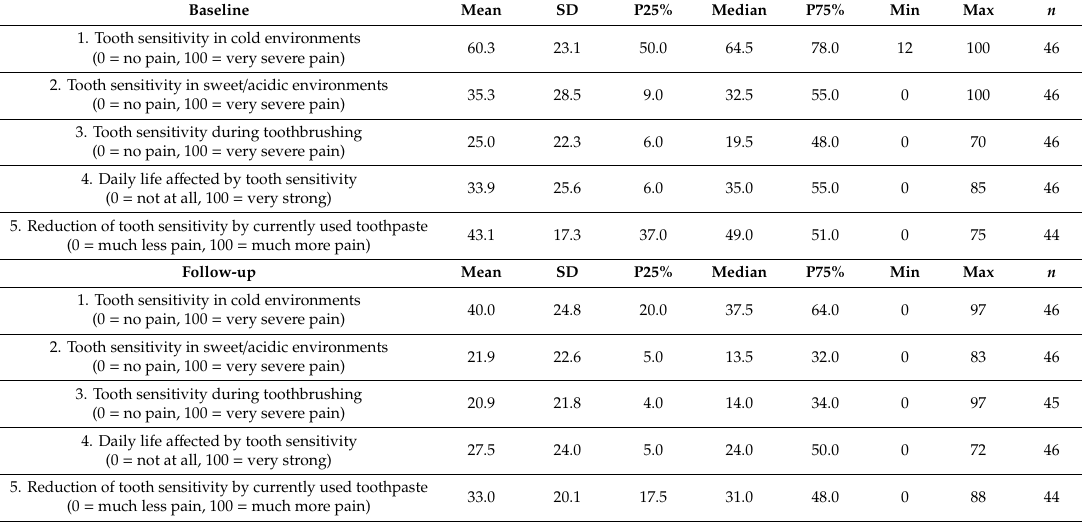
Table 4. Subjective parameters of dentin hypersensitivity at baseline and at follow-up (after 4-week use of HAP